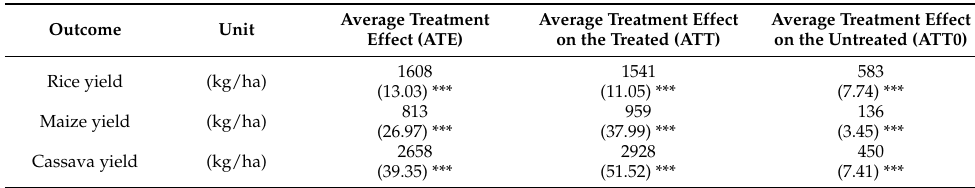
Table 3. Endogenous treatment effect estimates of the impact of use of climate information services on crop